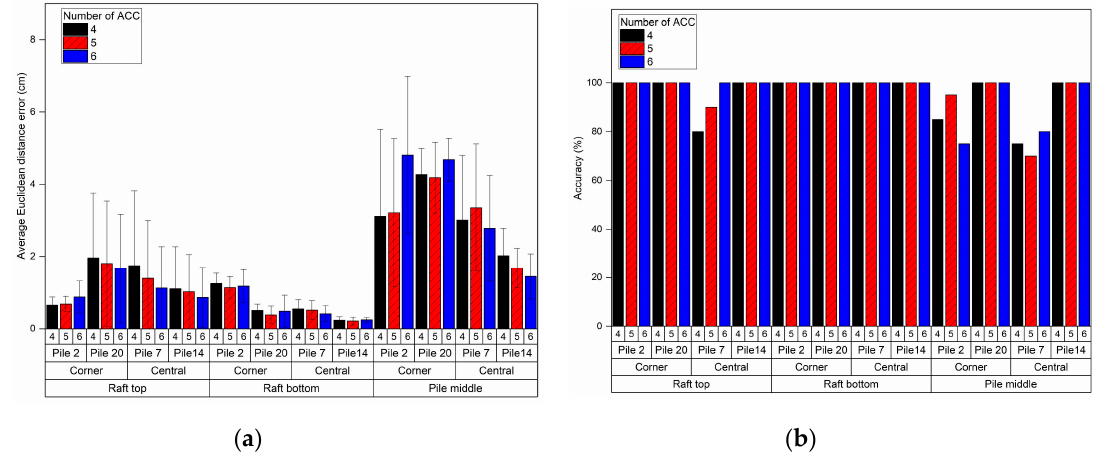
Figure 12. The accuracy improvement in source location by changing the number of sensors used for source localization: ( a ) average Euclidean distance error, ( b ) zoning accuracy.